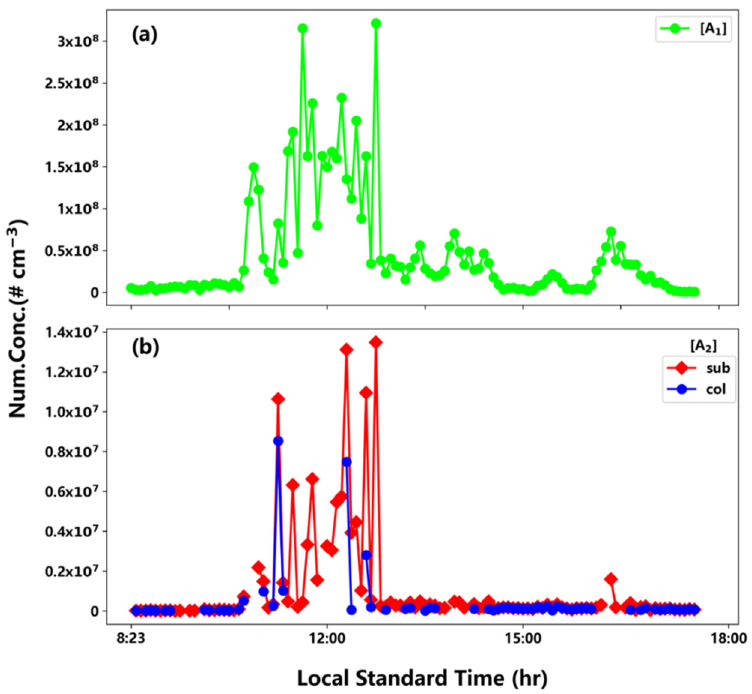
Figure 2. Temporal profiles of sulfuric acid concentration ( a ) and neutral dimer concentrations ( b ) with sub- or collision rate IIC corrections during the event on August 22. Table 1. The average concentrations of sulfuric acid monomers and dimers with sub-collision rate corrections for all the events in this study.